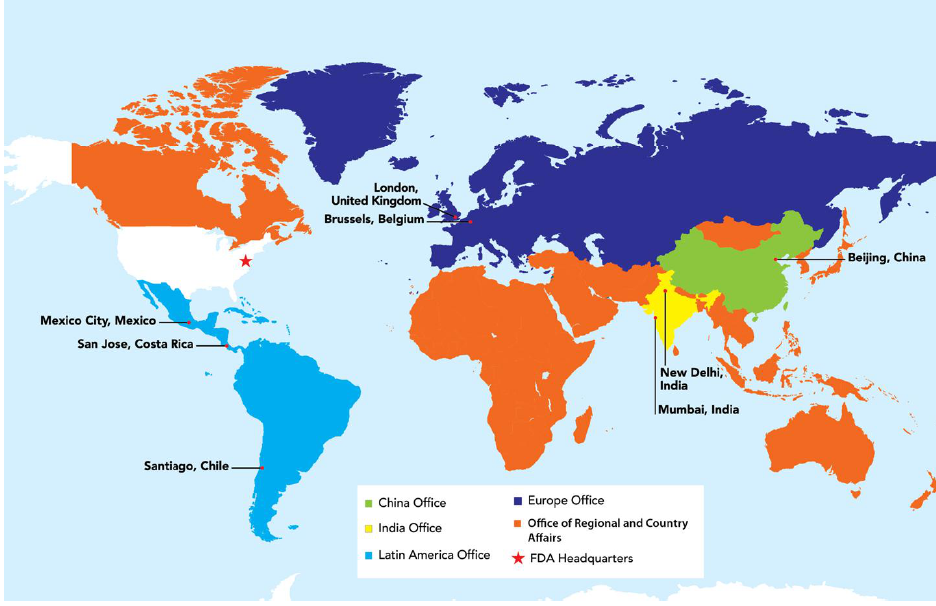
Figure 3. USFDA Foreign Office